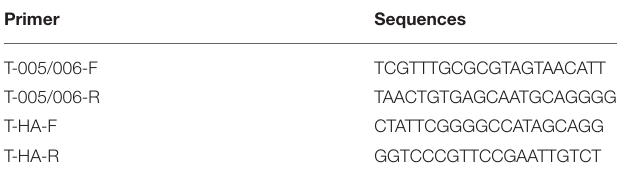
TABLE 3 | Primers used for knock-in